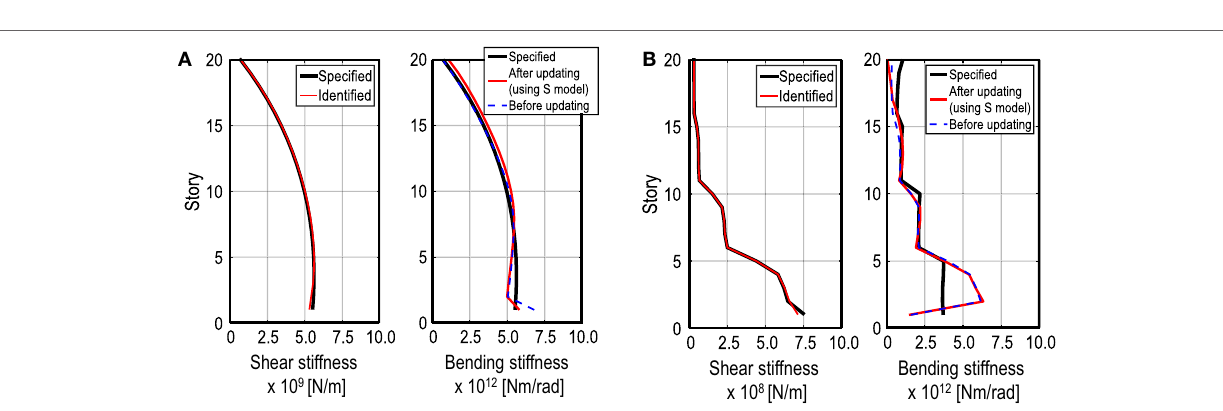
Frontiers in Built Environment |